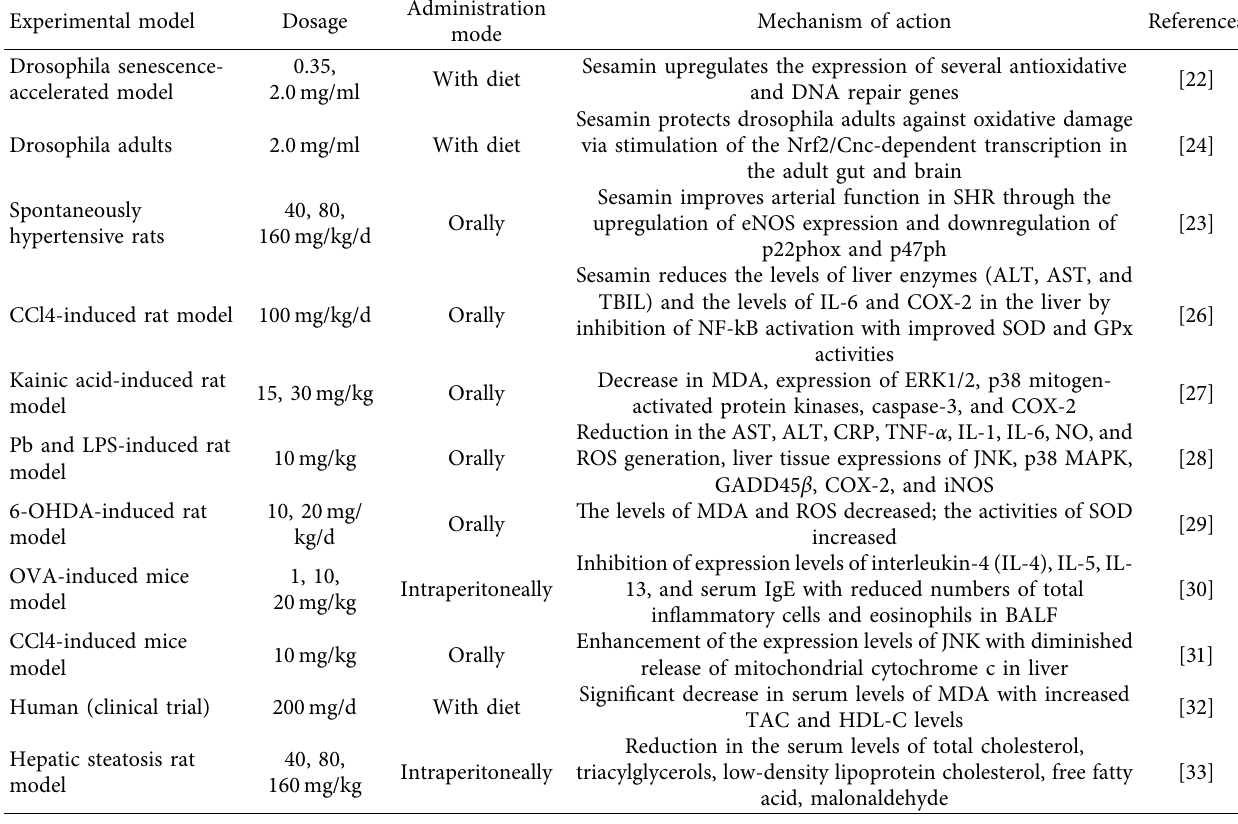
Table 1: Antioxidant activity of sesamin.